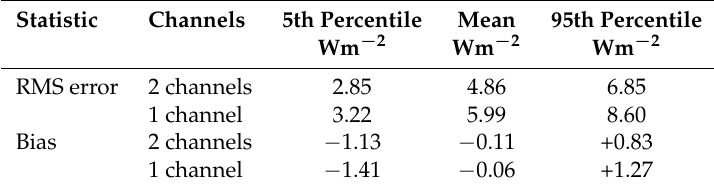
Table 2. Statistics of the RMS error and bias of the OLR estimation with Equation (1) (2 channels) and Equation (2) (1